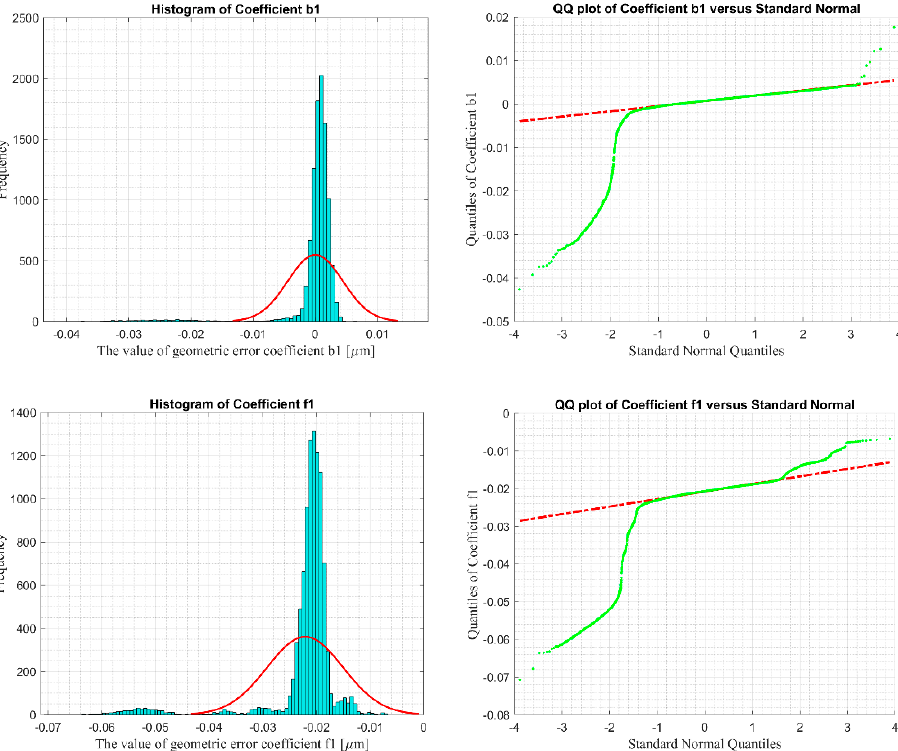
Figure 14. Distributions of the uncertainties of some geometric error correction coefficients.